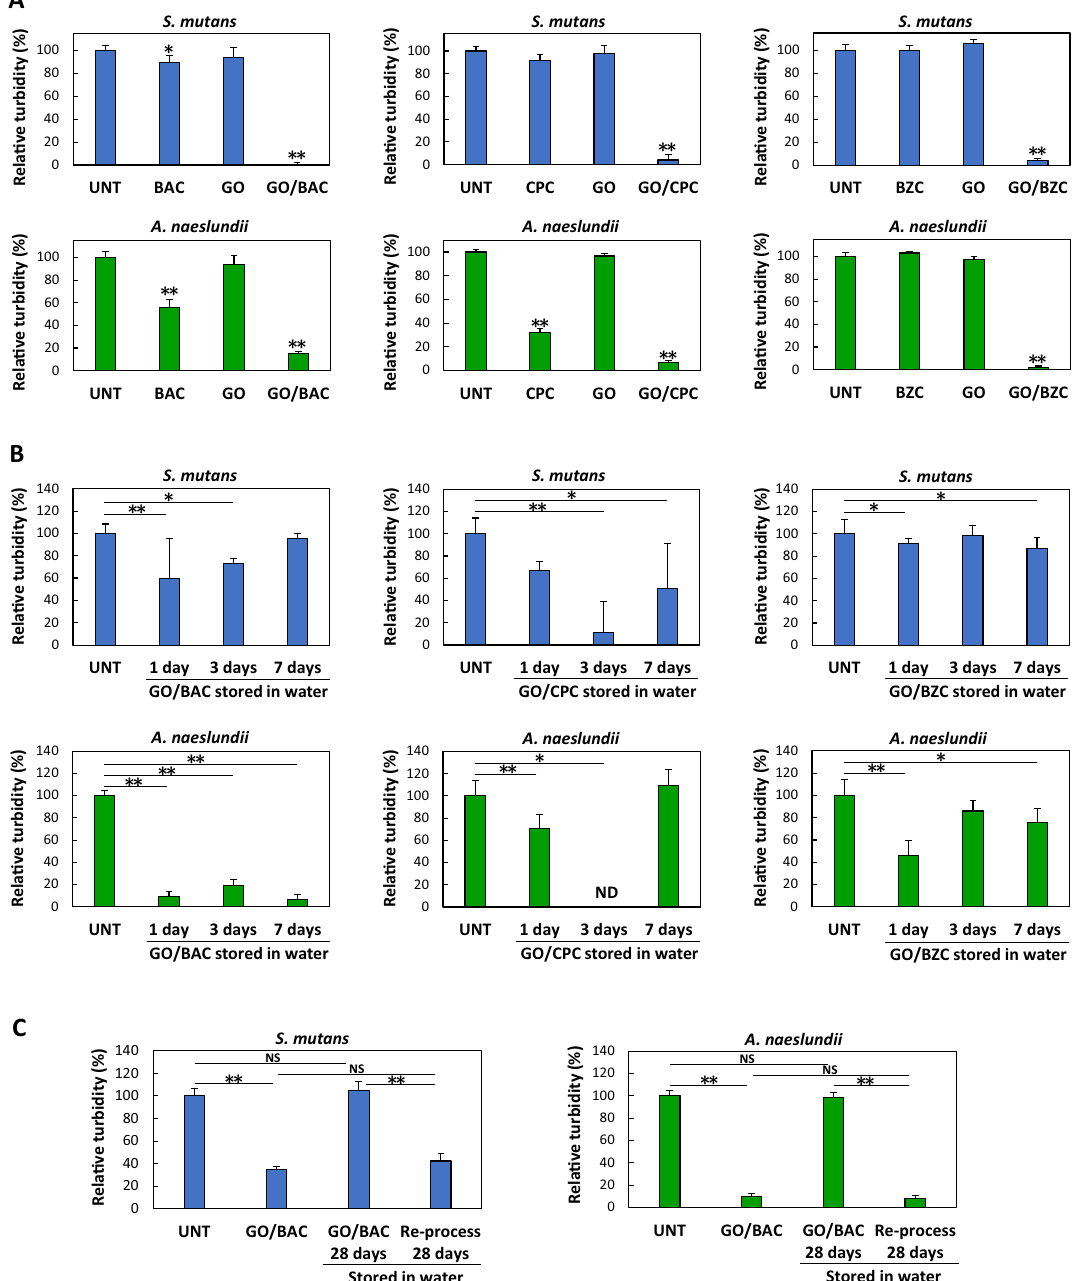
Figure 4. Antibacterial assessment of GO/CSAA. ( A ) Relative turbidity (n = 6, mean + standard deviation) after 24 h incubation of S. mutans (top) and A. naeslundii (bottom) cultured on each well substrate. *P < 0.05 vs. UNT. **P < 0.01 vs. all other groups. ( B ) Long-term durability of GO/CSAA under water storage. Relative turbidity (n = 6, mean + standard deviation) of S. mutans (top) and A. naeslundii (bottom) cultured on each well substrate. *P < 0.05, **P < 0.01. ( C) Antibacterial assessments after reprocessing with BAC. Relative turbidity (n = 6, mean + standard deviation) of S. mutans (left) and A. naeslundii (right) cultured on each well substrate. **P < 0.01. Statistical analysis: two-tailed one-way ANOVA with post-hoc Tukey HSD test. BAC benzalkonium chloride, BZC benzethonium chloride, CPC cetylpyridinium chloride, CSAA cationic surface active agent, GO graphene oxide, ND not detected, NS not significant, UNT